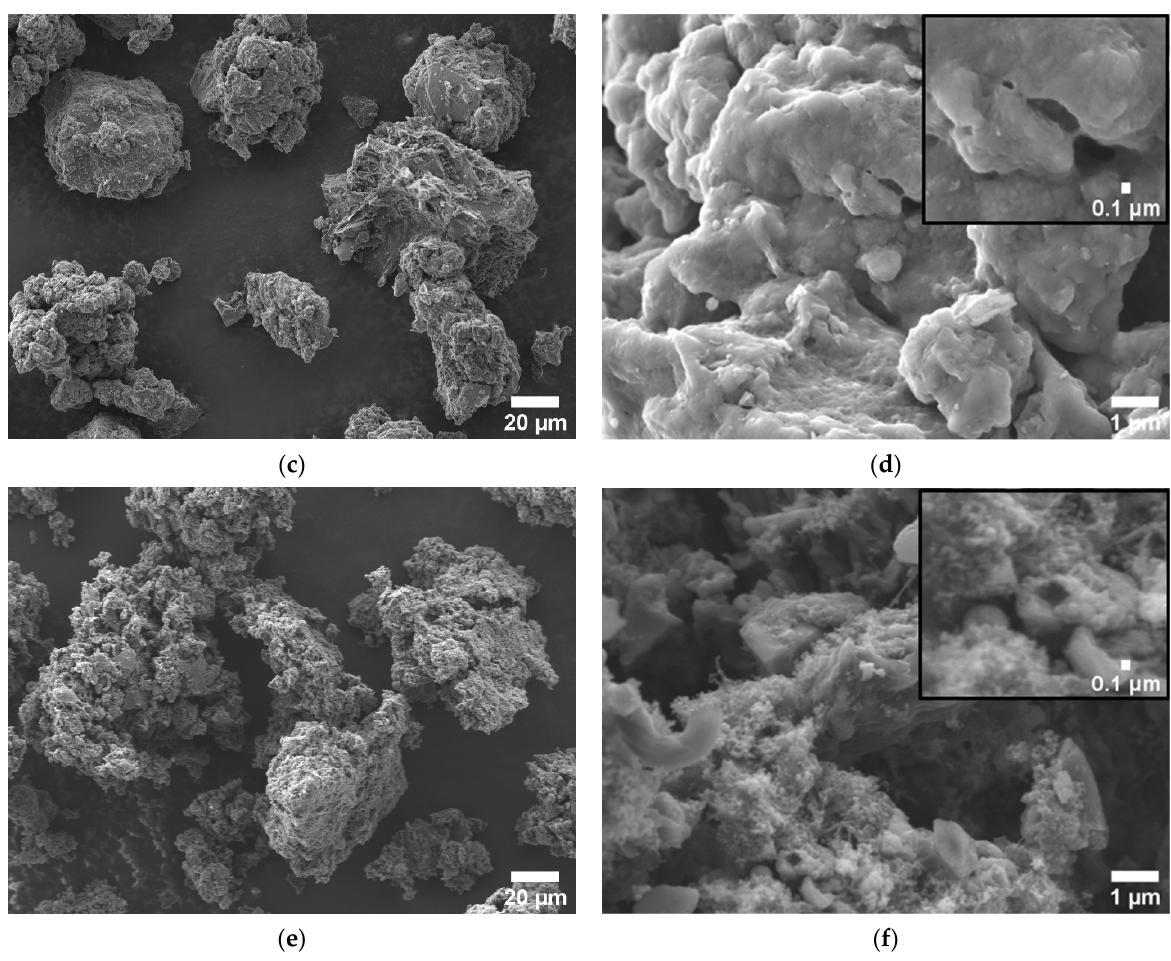
Figure 1. SEM images with different magnification of ( a , b ) BPW@H 3 PO 4 , ( c , d ) BPW@ZnCl 2 , and ( e , f ) BPW@KOH.